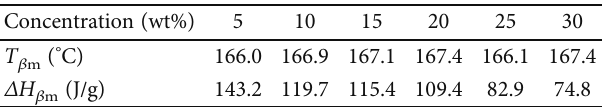
Table 4: Crystallization and melting parameters of PP/WBG/GF-P at di ff erent GF-P wt%